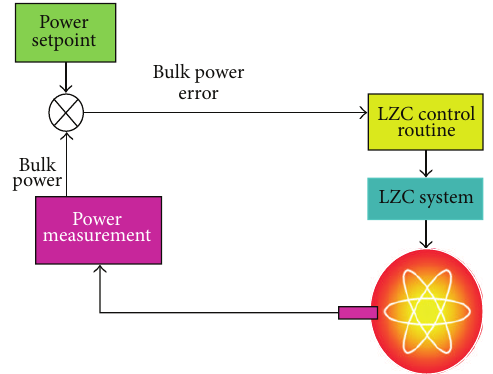
Figure 1: Simplified reactor control scheme in CANDU , where Liquid Zone Control system is shown as a means for fine reactivity control and reduction of power